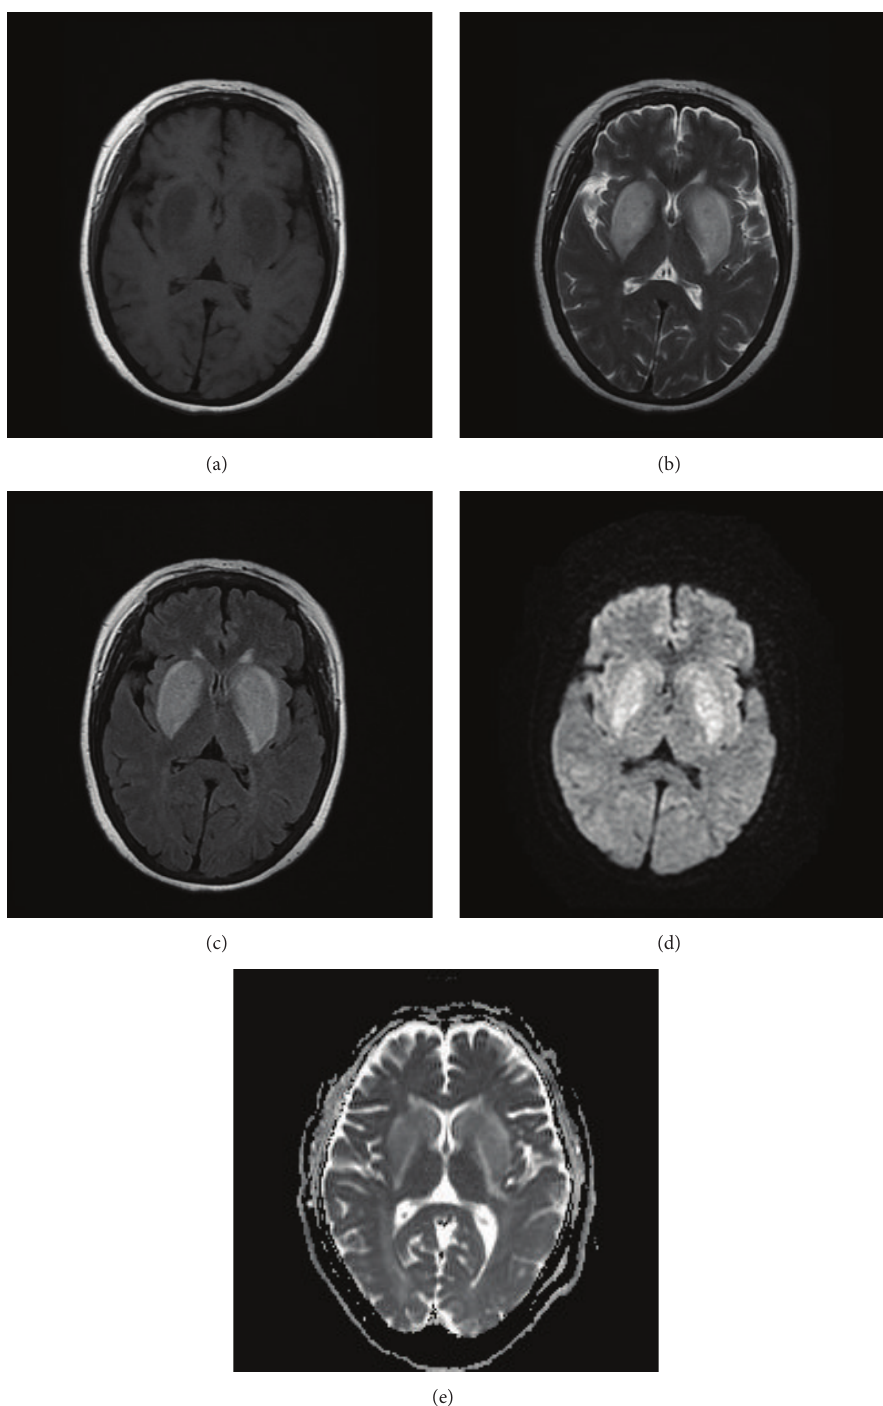
Figure 1: (a) Axial brain MRI showed symmetric hypointensity in the bilateral basal ganglia on T1-weighted images. (b, c) Axial brain MRI showed symmetric hyperintensity in the focal region on T2-weighted images and FLAIR images. (d) Diffusion-weighted imaging revealed slightly higher inhomogeneous signals in the involved regions. (e) ADC map revealed that the ADC value of the involved regions is not